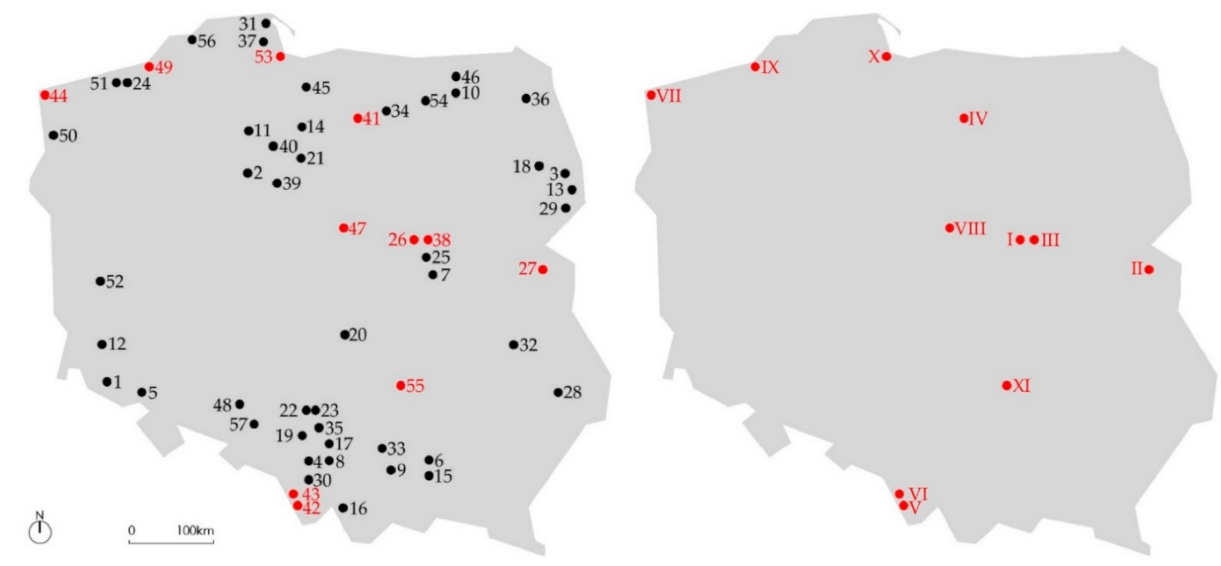
Figure 5. ( Left ): location of 57 amphitheaters and odeons in Poland (number following Table 1, odeons marked red). ( Right ): location of 11 odeons (numbers follow Table 2). Original